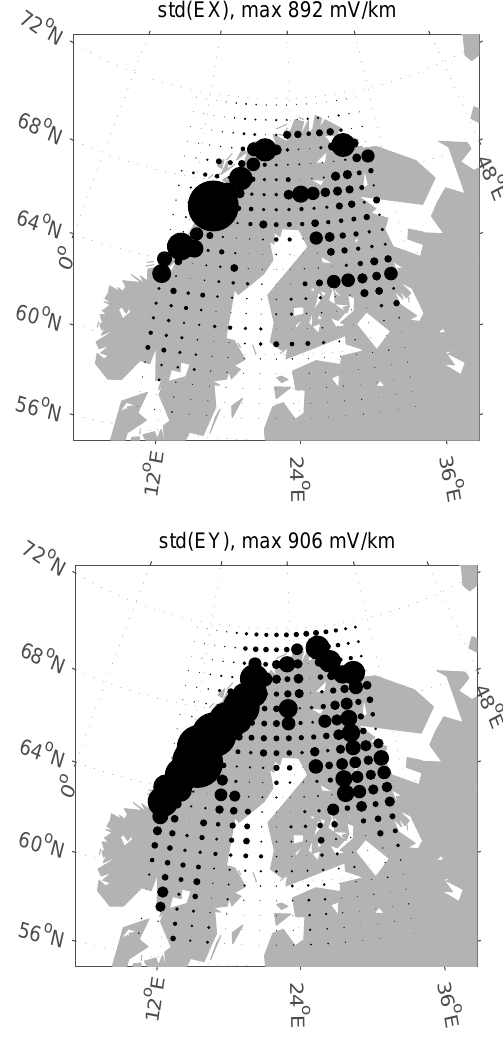
Fig. 4. Standard deviation of the modeled geoelectric field varia- tions at the Earth’s surface at some of the grid points of the volume- 3-D code. The maximum standard deviations are indicated in the titles of the